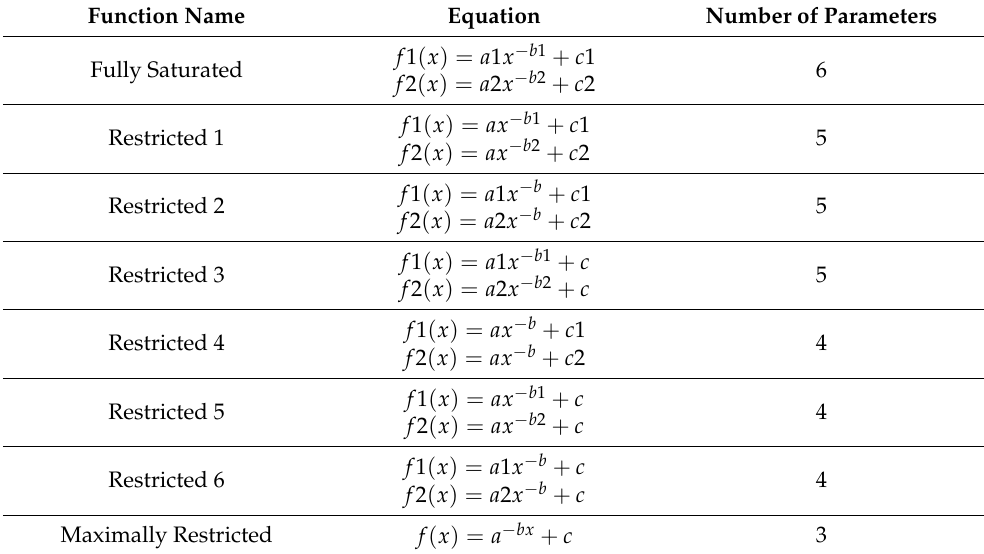
Table 4. Lattice of power law functions. The fully saturated model has six parameters, whereas the maximally restricted model has three parameters. f 1( x ) indicates the function fitted to the learning Glass pattern (GP) group, and f 2( x ) indicates the function fitted to the learning random dot kinematogram (RDK) group. Function Name